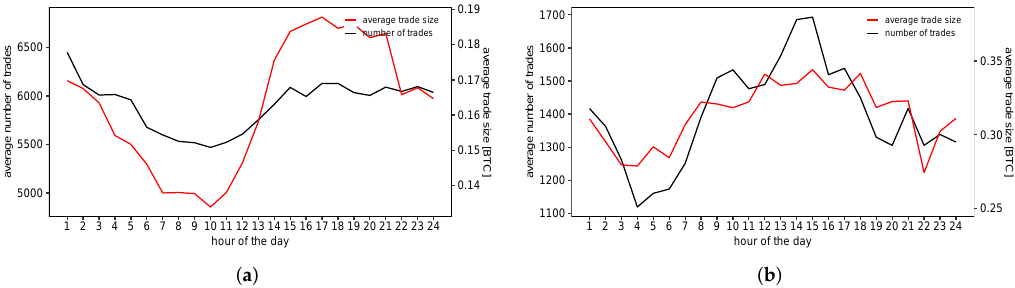
Figure A6. Intraday dynamics of trading activity. We plot the average hourly trade size and the average hourly number of trades as a function of the hour of the day. ( a ) Coinbase BTC/USD market. The hour of the day is given in San Francisco time; ( b ) Bitstamp BTC/USD market. The hour of the day is given in Berlin